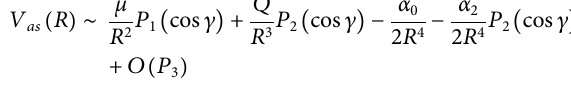
Frontiers in Chemistry |